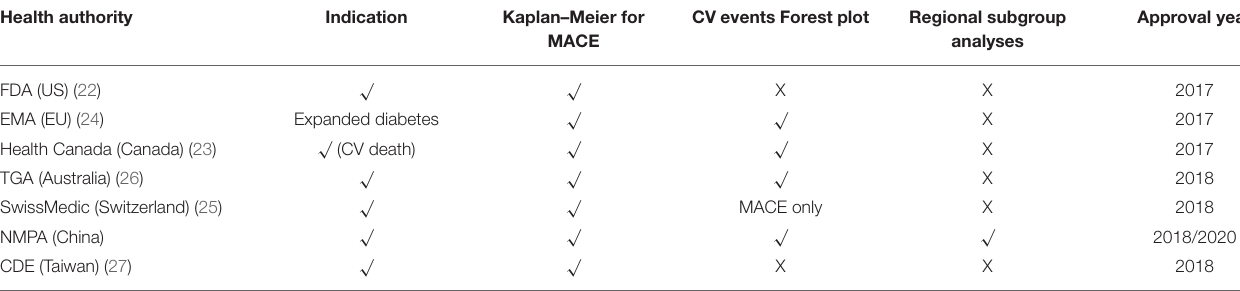
TABLE 3 | Regulatory approvals of LEADER in the Victoza ® label. Health